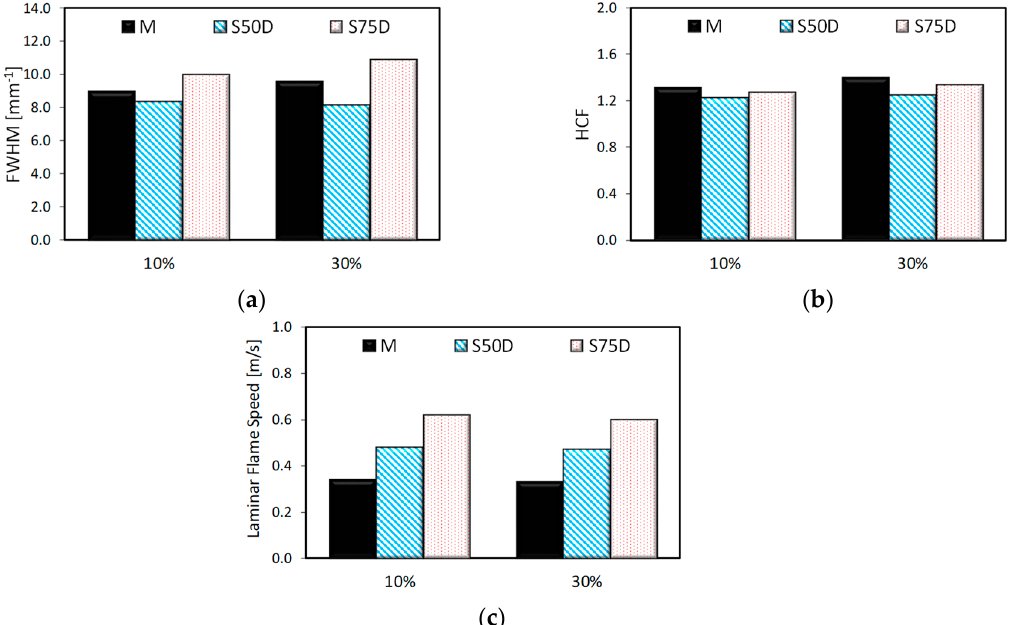
Figure 21. ( a ) Flame curvature, ( b ) average Heywood Circularity Factor, and ( c ) laminar flame speed in engine-like conditions for methane and real syngas mixtures at 10% and 30% flame sizes with respect to the piston area, during lean fueling ( λ =